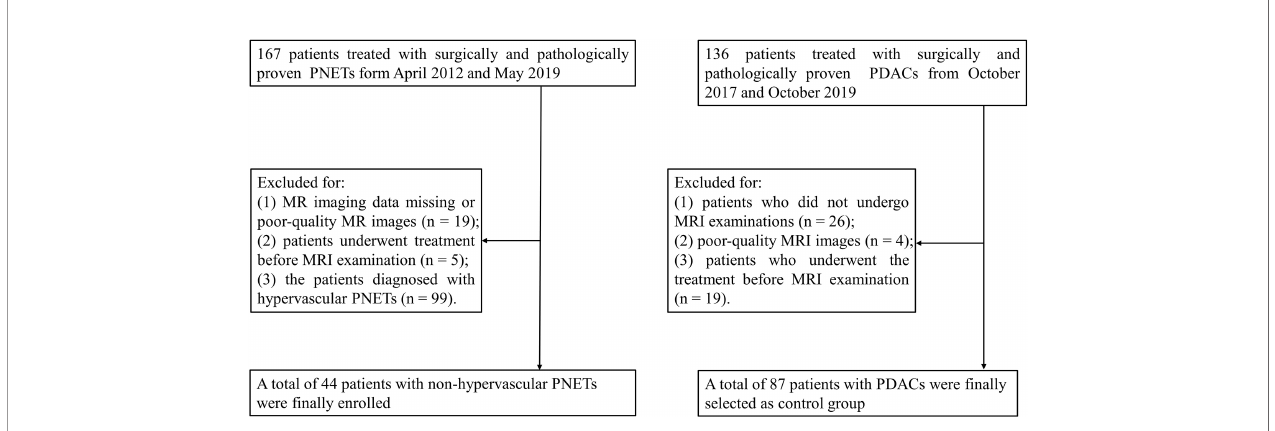
FIGURE 1 | Flowchart of the selection of patients with non-hypervascular pancreatic neuroendocrine tumors (PNETs) and pancreatic ductal adenocarcinomas